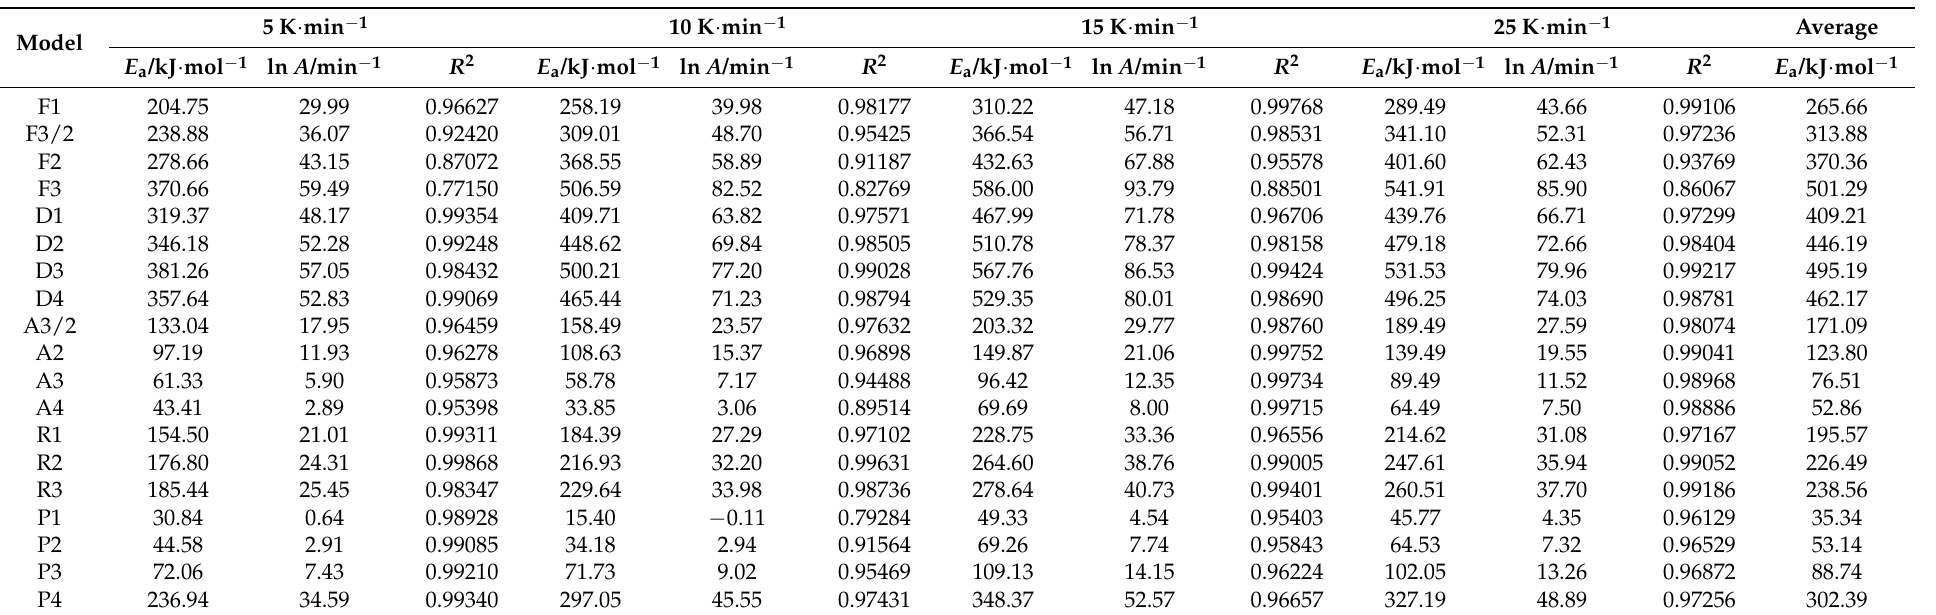
Table A2. The kinetic parameters of IB calculated by KC method at different heating